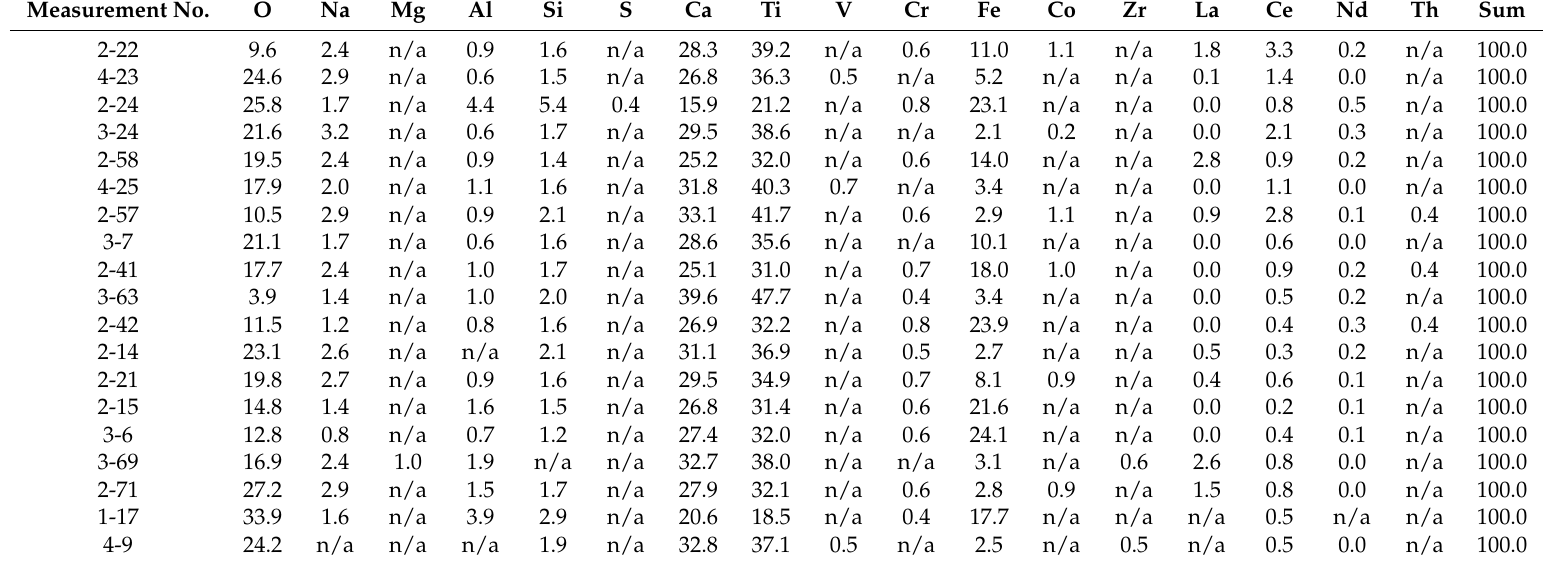
Table A1. Normalised HRTEM-EDS semi-quantitative analysis of calcium ferrotitanate